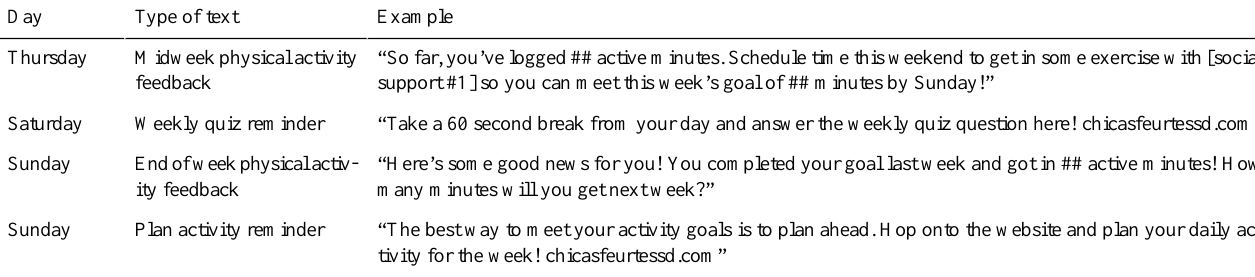
Table 1. Sample text